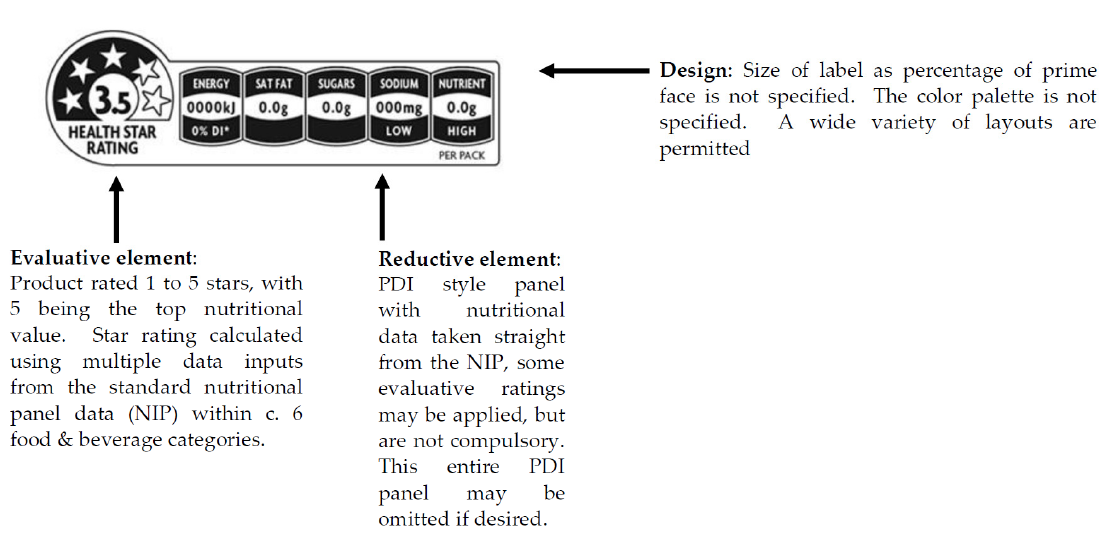
Figure 2. Health Star Rating (HSR) label.